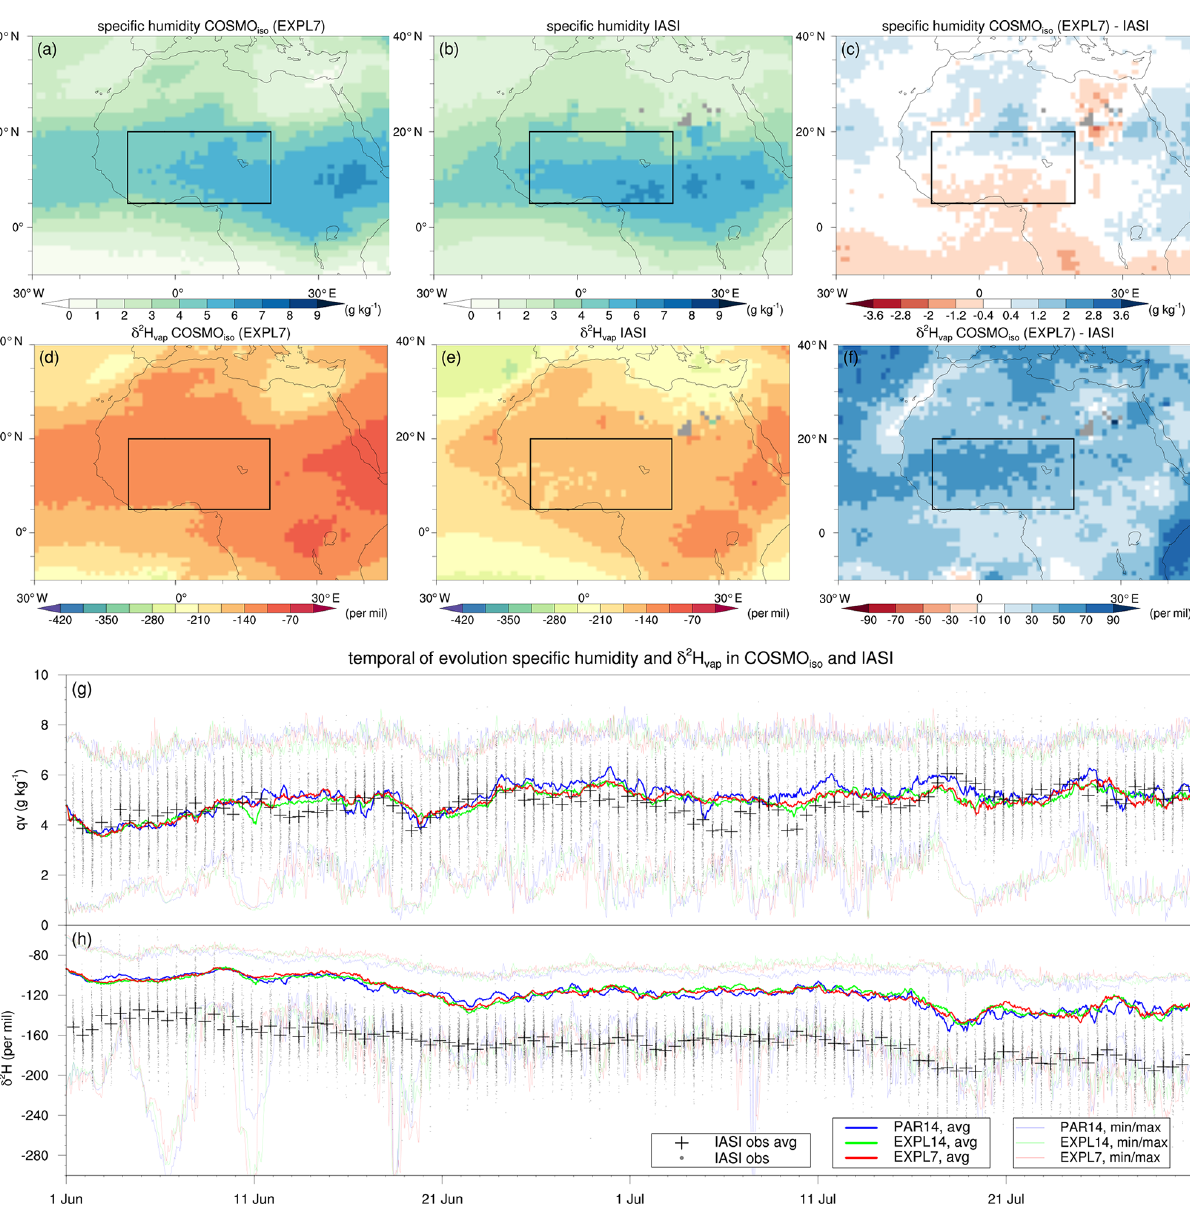
Figure 2. Spatial distribution and temporal evolution of specific humidity and water vapour isotopes in COSMO iso and IASI observations at 4220ma.s.l. for the 2-month simulation period of June–July 2016. The panels show the (a–c) specific humidity (gkg − 1 ) and (d–f) δ 2 H in water vapour (‰) from (a, d) EXPL7, (b, e) IASI, and (c, f) the difference between EXPL7 and IASI. The bottom panels show the temporal evolution of (g) specific humidity (gkg − 1 ) and (h) δ 2 H in vapour (‰) based on domain averages and minima and maxima values for grid points in the region of interest (see Fig. 1) for all three COSMO iso model simulations and IASI observations, as indicated by the legend. For COSMO iso output, only data where the sum of total column cloud ice, snow, liquid water, and rain (TQ) remains below a threshold of 0.01kgm − 2 are used; see the text for